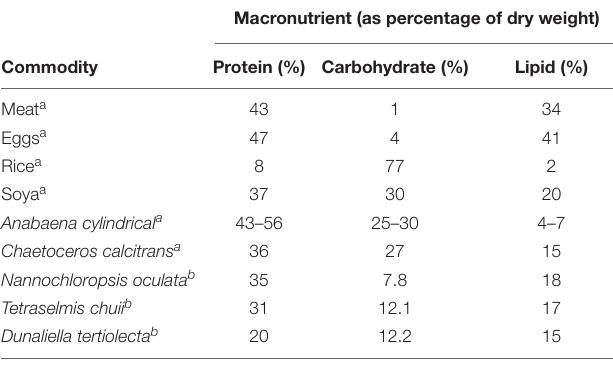
TABLE 1 | Comparing protein, carbohydrate and lipid contents between conventional food commodities and marine microalgae (on a dry weight basis). Macronutrient (as percentage of dry